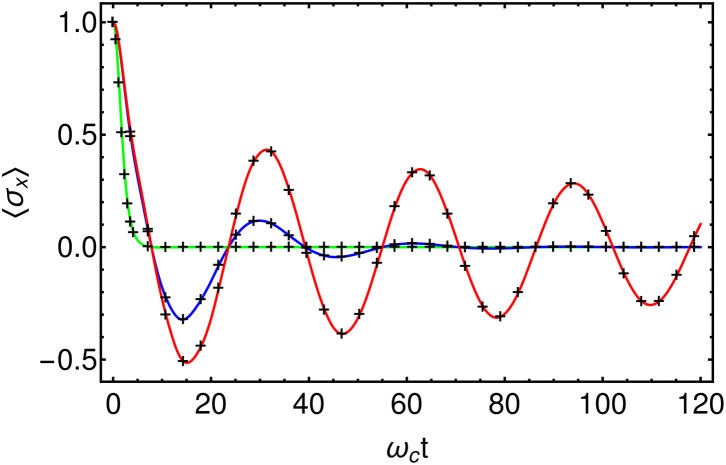
Comparison of T-TEDOPA (Black crosses) with the exact solution for the Independent-Boson-Model at β = 100 (Red), β = 10 (Blue), and β = 1 (Green). HS=ω02σz, AS = σz, J(ω)=2αωc(ωωc)sΘ(ω−ωc)),, α = 0.1, s = 1, ω0 = 0.2ωc.